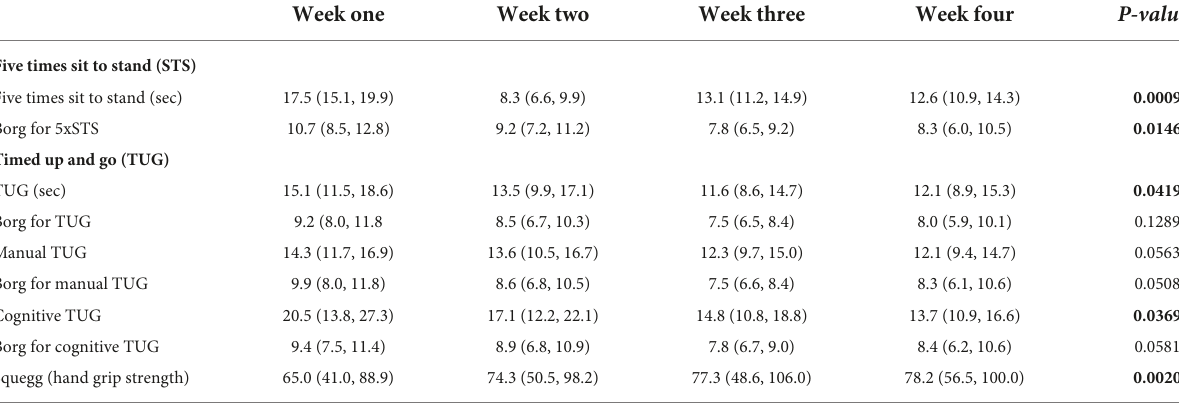
TABLE 2 Physical therapy data. Week one Week two Week three Week four P-value